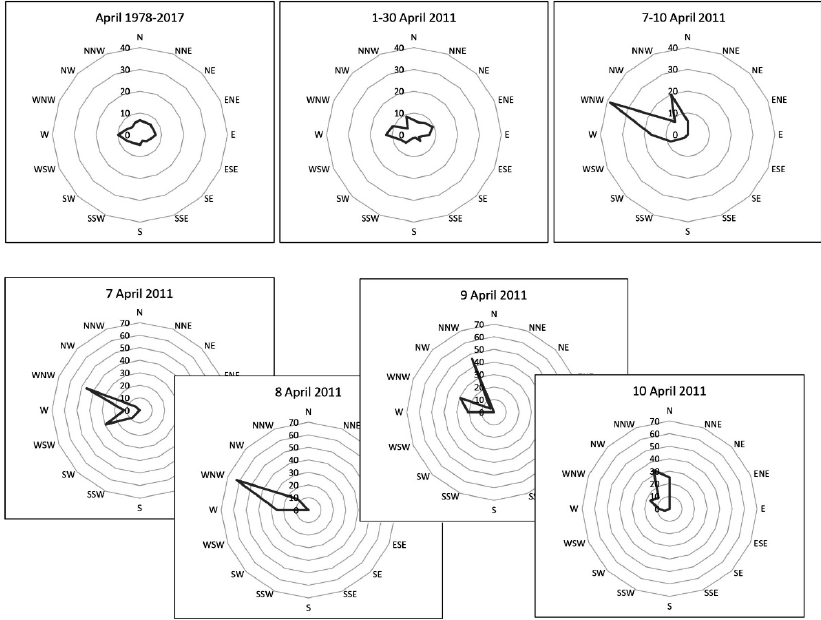
Figure 2. Wind direction in days with extreme aeolian processes and in the long-term period